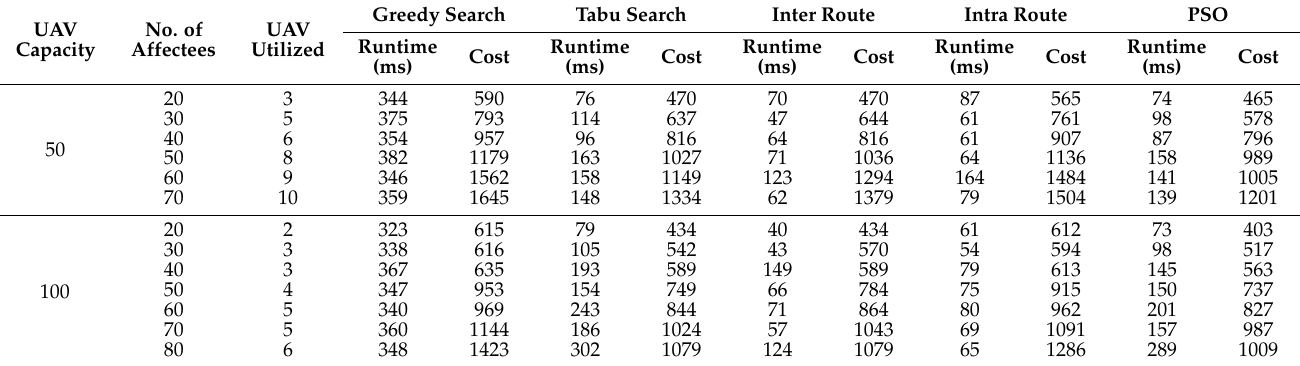
Table 6. Experimental Results for Solving VRP using Greedy Search, Tabu Search, Inter Route, and Intra Route Search Heuristics, With Total Vehicles =